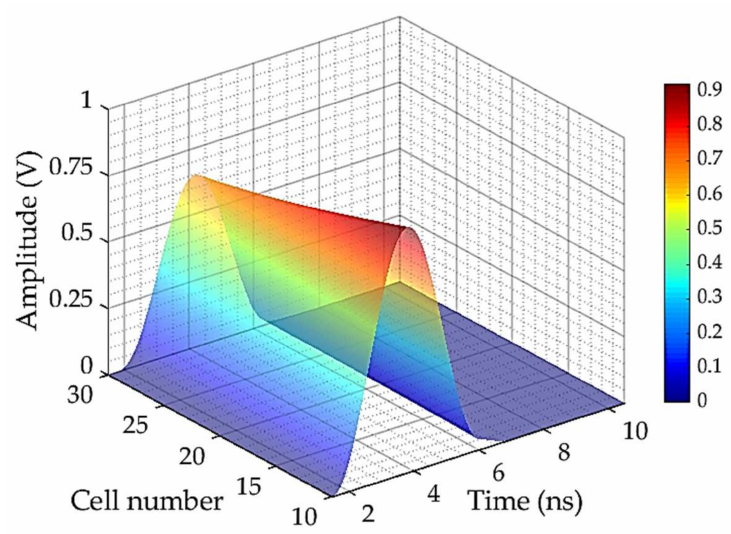
Figure 5. Three-dimensional spatiotemporal evolution of a bright soliton along lossy NLTL.